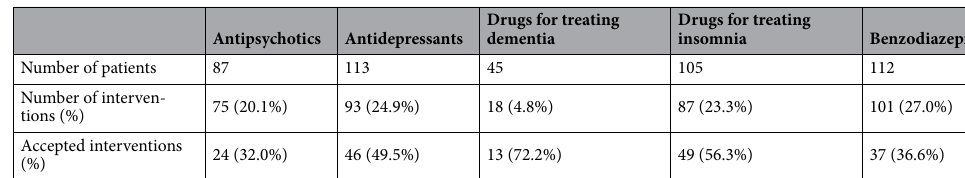
Antipsychotics Antidepressants